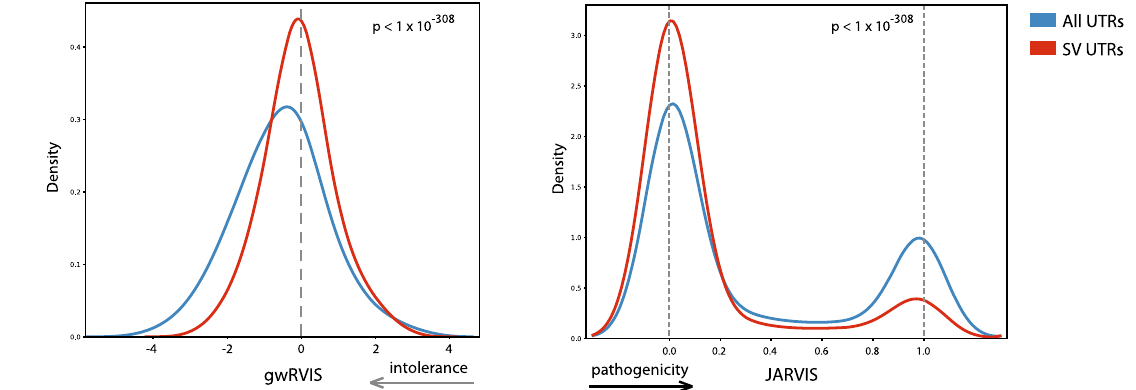
Fig. 6 JARVIS and gwRVIS performance on structural variants. a ROC curves from classi fi cation of nongenic structural variants (intergenic) against different sets of putative pathogenic genic SVs, using a tenfold cross-validation approach with a logistic regression model on fi ve scores: JARVIS, gwRVIS, LINSIGHT, ncER, and Orion. One-sided DeLong ’ s tests have been performed to assess the statistical signi fi cance of the differences in predictive power between JARVIS and the rest of genome-wide scores. b gwRVIS distribution across the UTR regions for the subset of called structural variants vs. the entire genomic class (median gwRVIS: − 0.020 vs. − 0.51, two-sided Mann – Whitney U p < 1 × 10 − 308 ). Tolerance increases toward greater gwRVIS values. c JARVIS distribution across the UTR regions for the subset of called structural variants versus the entire genomic class (mean JARVIS: 0.147 vs. 0.326, two-sided Mann – Whitney U p < 1 × 10 − 308 ). Pathogenicity likelihood increases toward greater JARVIS